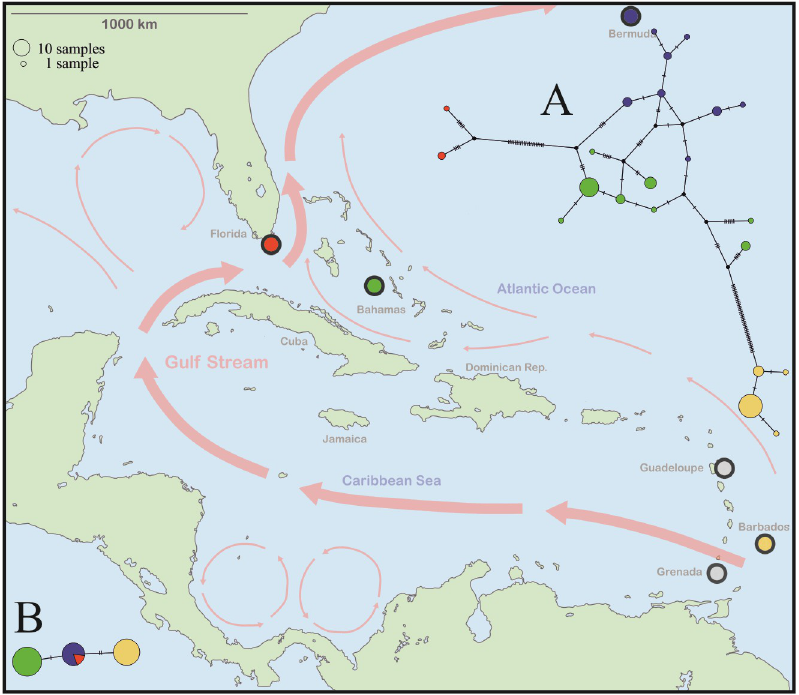
Fig 3. Map showing records of Fortuynia populations in the Caribbean and Western Atlantic area. Different colors refer to different locations whereas records given in grey refer to findings of single specimens (not included in morphometric and molecular genetic analyses). Red arrows indicate ocean currents and their directions. Inserts showing haplotype network based on COI -2 (A), respectively, 18S (B) sequences. Colors of haplotypes refer to geographic